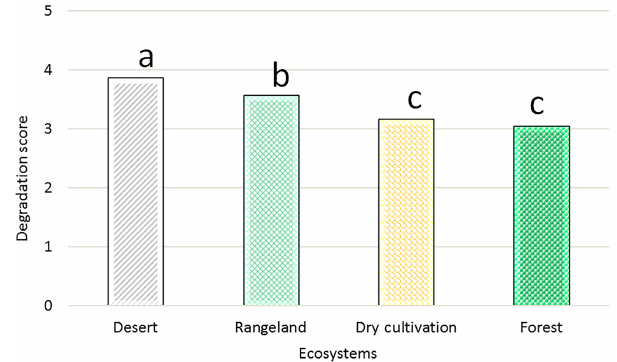
Figure 7. Average of degradation amount in the different ecosystem types using the Duncan test: a, b and c show difference among class means at a significant level of 0.01.